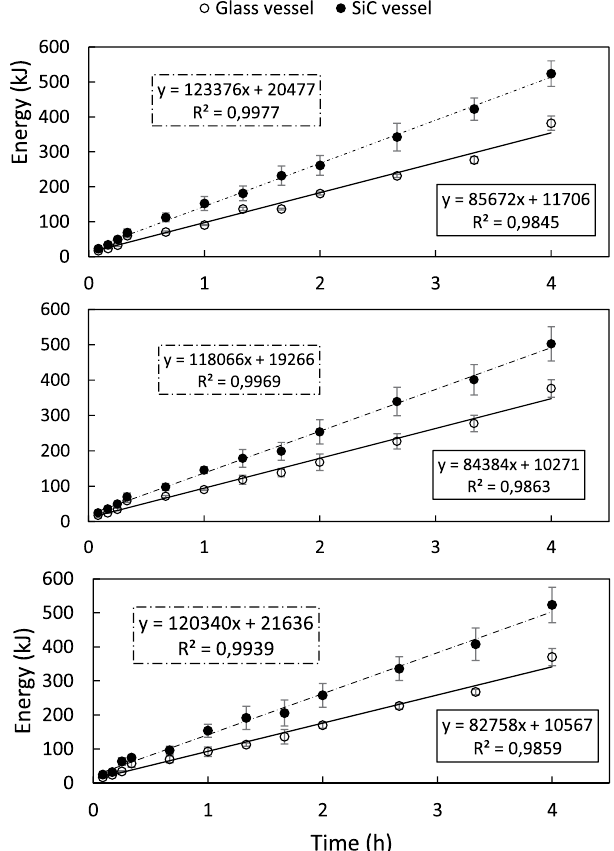
Figure 8. Comparison of energy consumption between a borosilicate glass and SiC reaction vessel using ( A ) cellulose, ( B ) D-glucose and ( C ) D-fructose as a